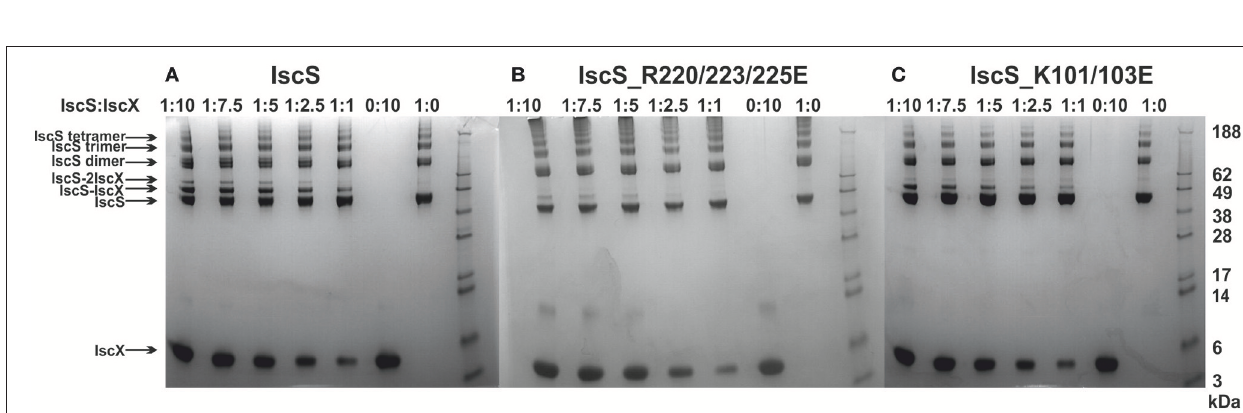
Frontiers in Molecular Biosciences |